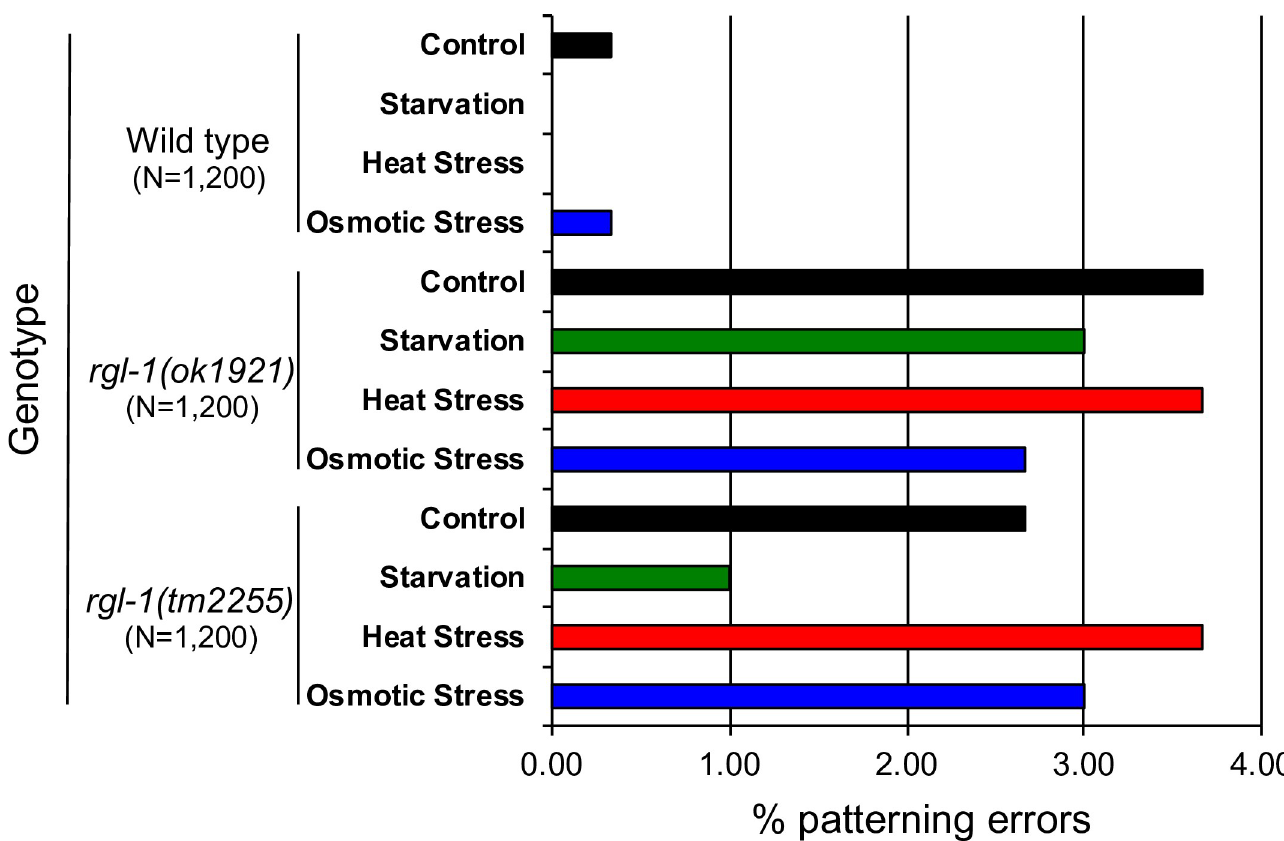
Fig 6. Deletion of RGL-1 increases patterning errors but not susceptibility to environmental stress. rgl-1 deletions ok1921 and tm2255 , introgressed to the wild type for eight generations (DV2696, DV2697), caused 15-fold increased patterning defects compared to the wild type. (N = 1,200 per genotype, pooled from 300 for each condition.) P < 0.0001 for each genotype, P > 0.05 between environmental